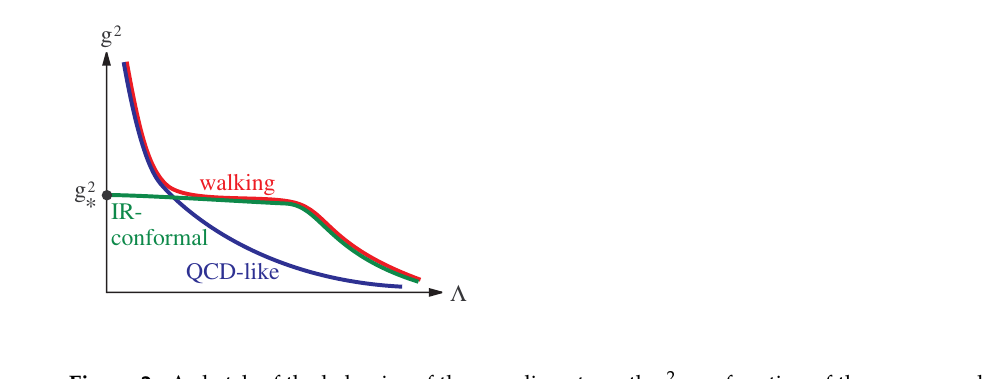
Figure 2. A sketch of the behavior of the coupling strength g 2 as a function of the energy scale Λ for QCD-like, walking, and infrared conformal